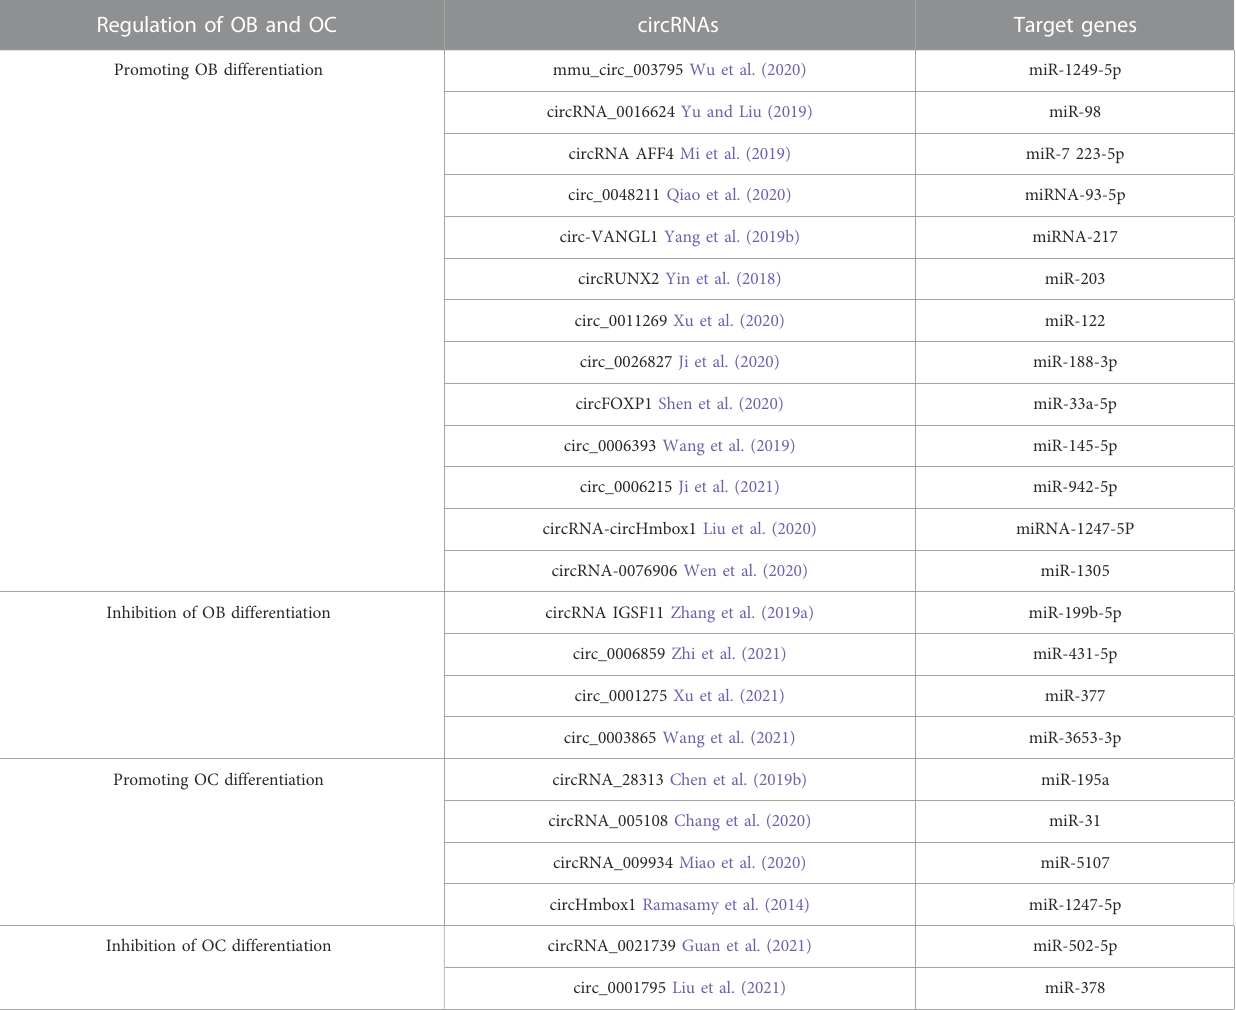
TABLE 5 circRNAs are implicated in the control of bone